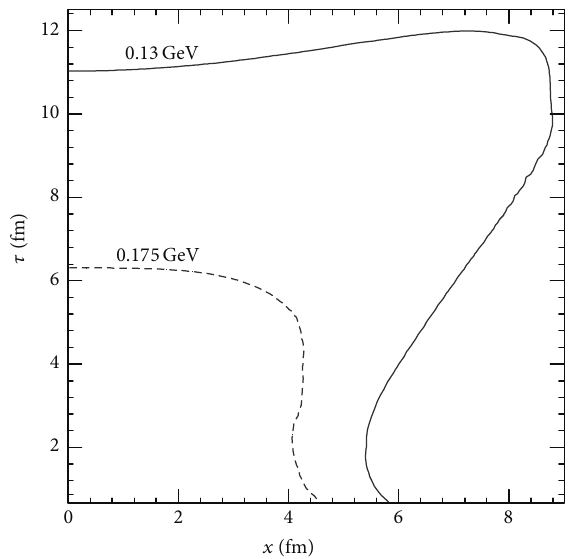
Figure 37: Constant temperature contours denoting space-time boundaries of the QGP and hadronic phase.